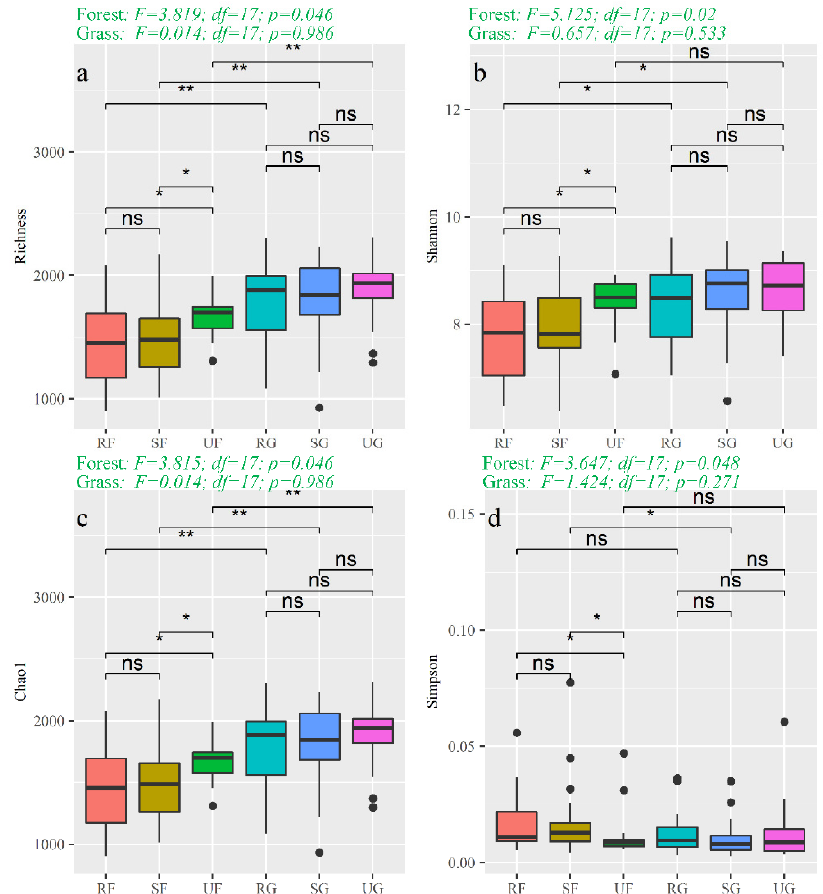
Figure 2. Box plot indicating bacterial alpha diversity indexes of richness ( a ), Shannon ( b ), chao1 ( c ) and Simpson ( d ) in different land cover categories . * p < 0.05, ** p < 0.01, ‘ns’ represent no significant difference. The box plot shows the percentiles of 25, 50 and 75. The upper limit of the box chart does not exceed 1.5 quartile value, and the lower limit is at least 1.5 quartile value. RF, SF, UF, RG, SG and UG represent rural forestland, suburban forestland, urban forestland, rural grassland, suburban grassland and urban grassland, respectively.